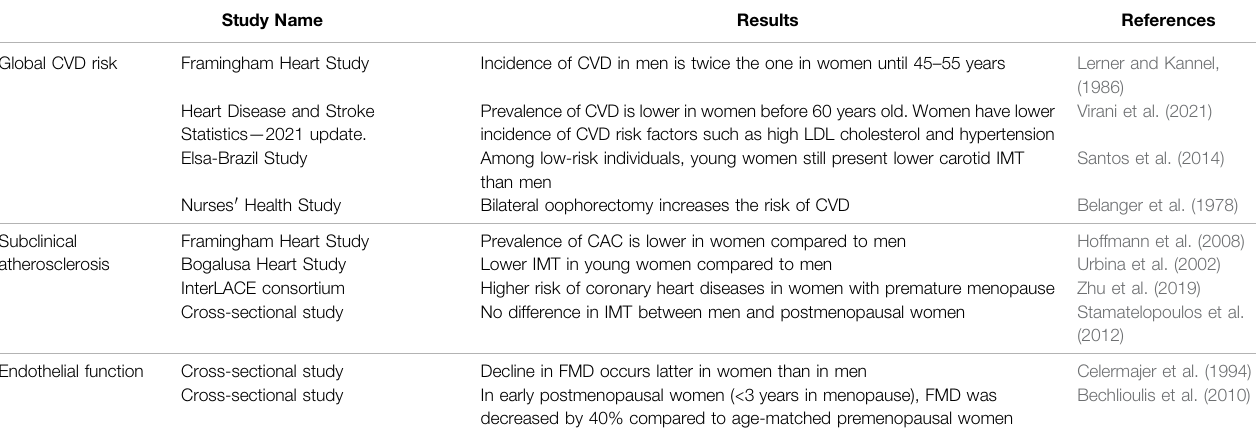
TABLE 1 | Clinical evidence of cardiovascular protection conferred by female hormones. CVD, cardiovascular diseases; IMT, intima-media thickness; CAC, coronary artery calci fi cation; FMD, fl ow-mediated